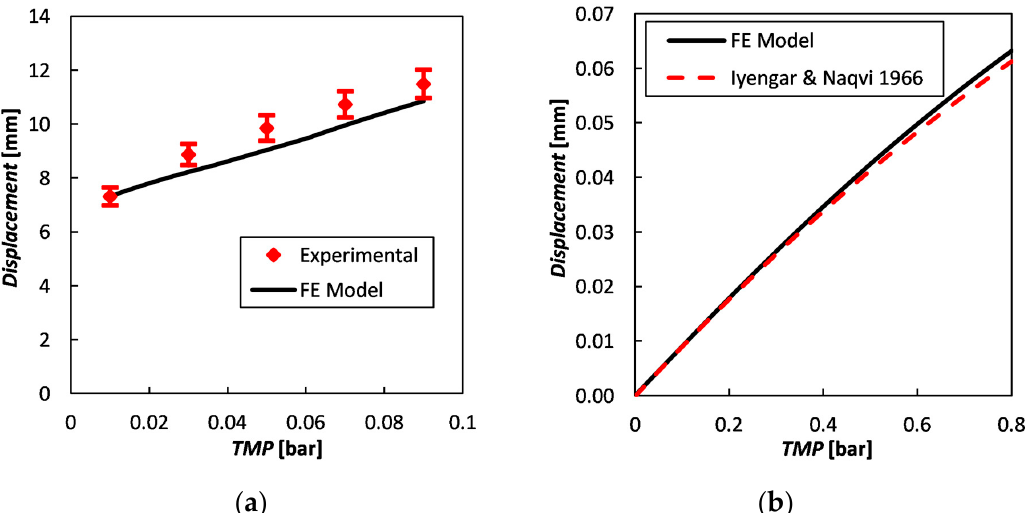
Figure 11. Maximum displacement for a square, edge-clamped membrane as a function of the trans- membrane pressure. Comparison of FE predictions (solid line) with ( a ) experimental results (symbols) of bulge tests on a 10 × 10 cm 2 sample and ( b ) the first-order analytical solution by Iyengar and Naqvi [58] for a 2 × 2 mm 2 membrane (dashed line).